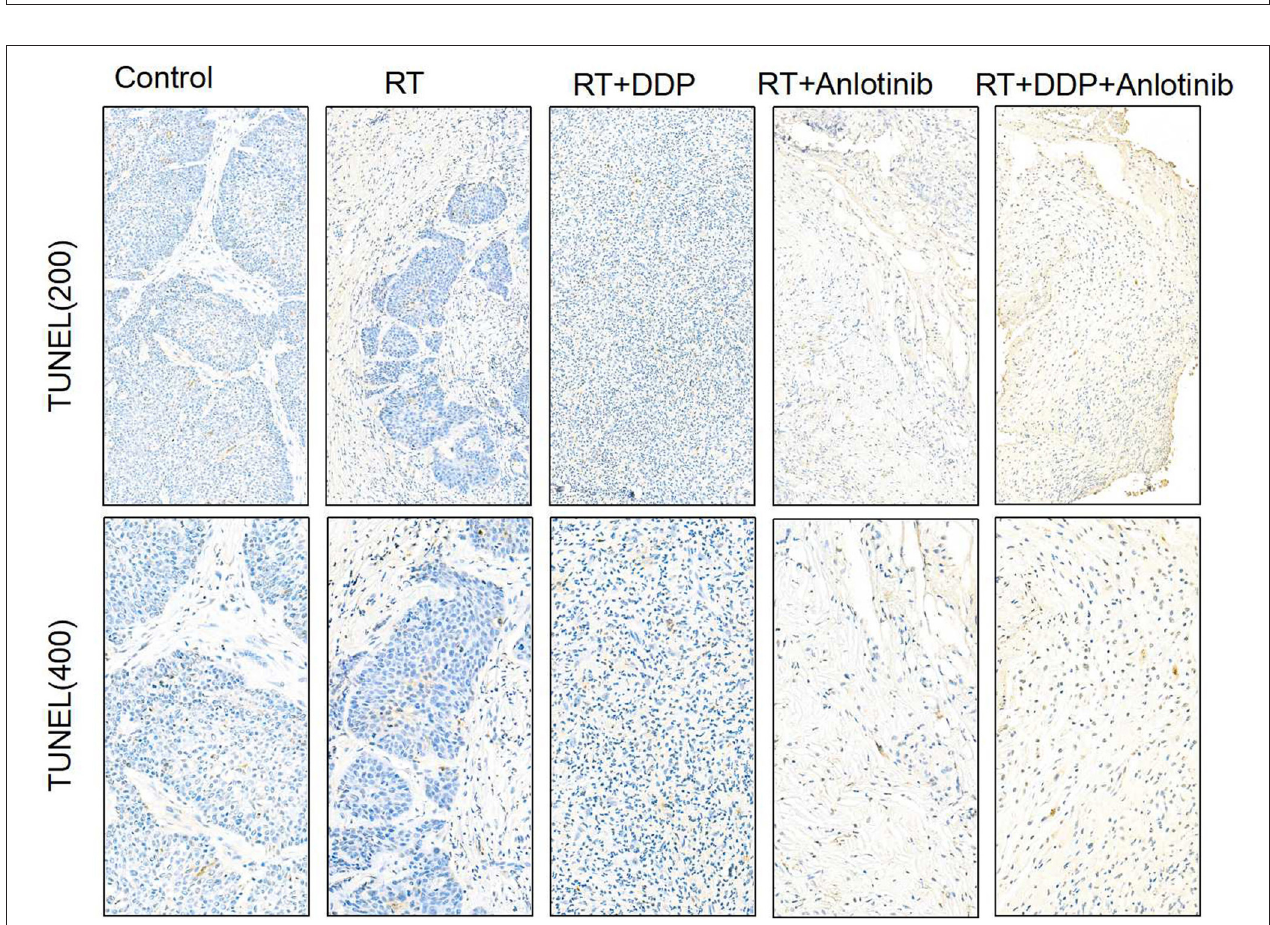
FIGURE 5 | Representative images of TUNEL assay showed that brownish yellow nuclei indicate the apoptotic cells. The four treatment groups showed different apoptosis rates in which anlotinib combined with chemoradiation-treated group was the highest compared with the control group. The figure provided is a representative image, and other images are provided in the Supplementary Files. RT, radiation therapy; DDP, cisplatin.